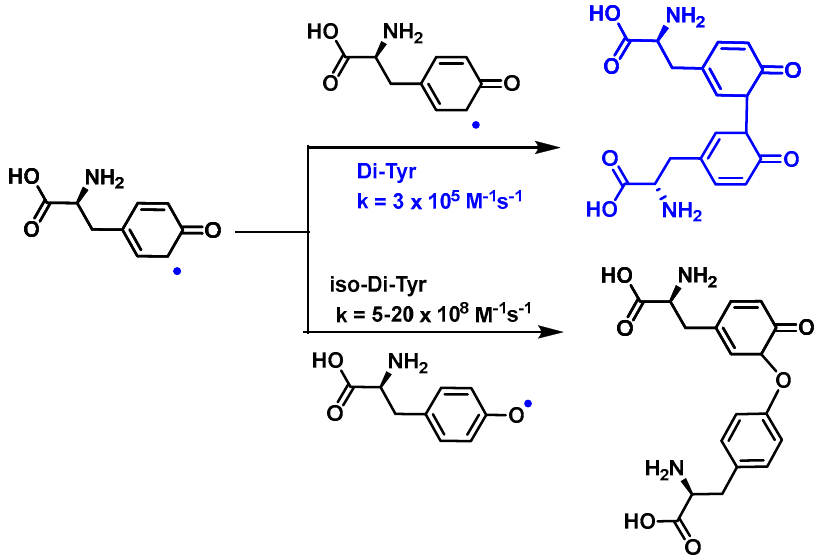
Figure 53. Formation and reactions of Tyr phenoxyl radicals Tyr • . Tyr • self-react to produce di-Tyr (o,o ′ -di-Tyr, blue; iso-di-Tyr, black).